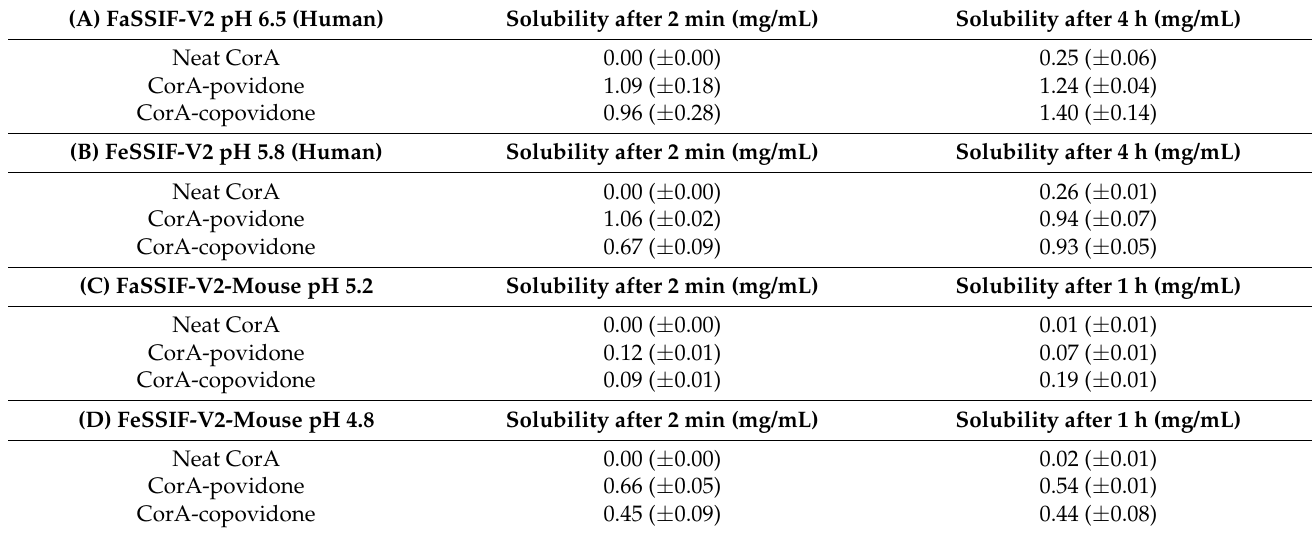
Table 3. Solubilities of neat CorA, CorA-povidone and CorA-copovidone ASD formulations over 4 h and 1 h, respectively. A: FaSSIF-V2 medium, pH 6.5; B: FeSSIF-V2, pH 5.8; C: FaSSIF-V2-mouse